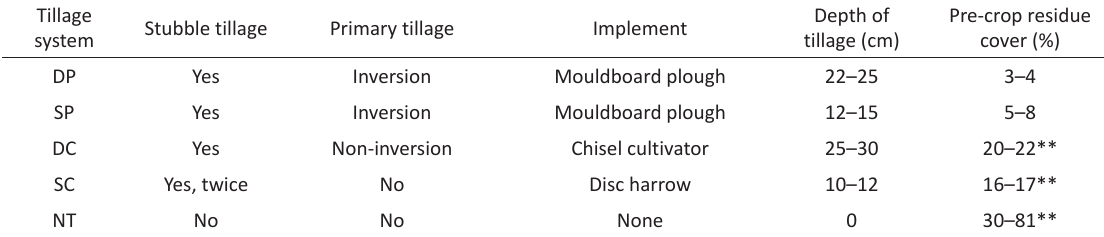
Table 4. Tillage methods used in the experiment Tillage system